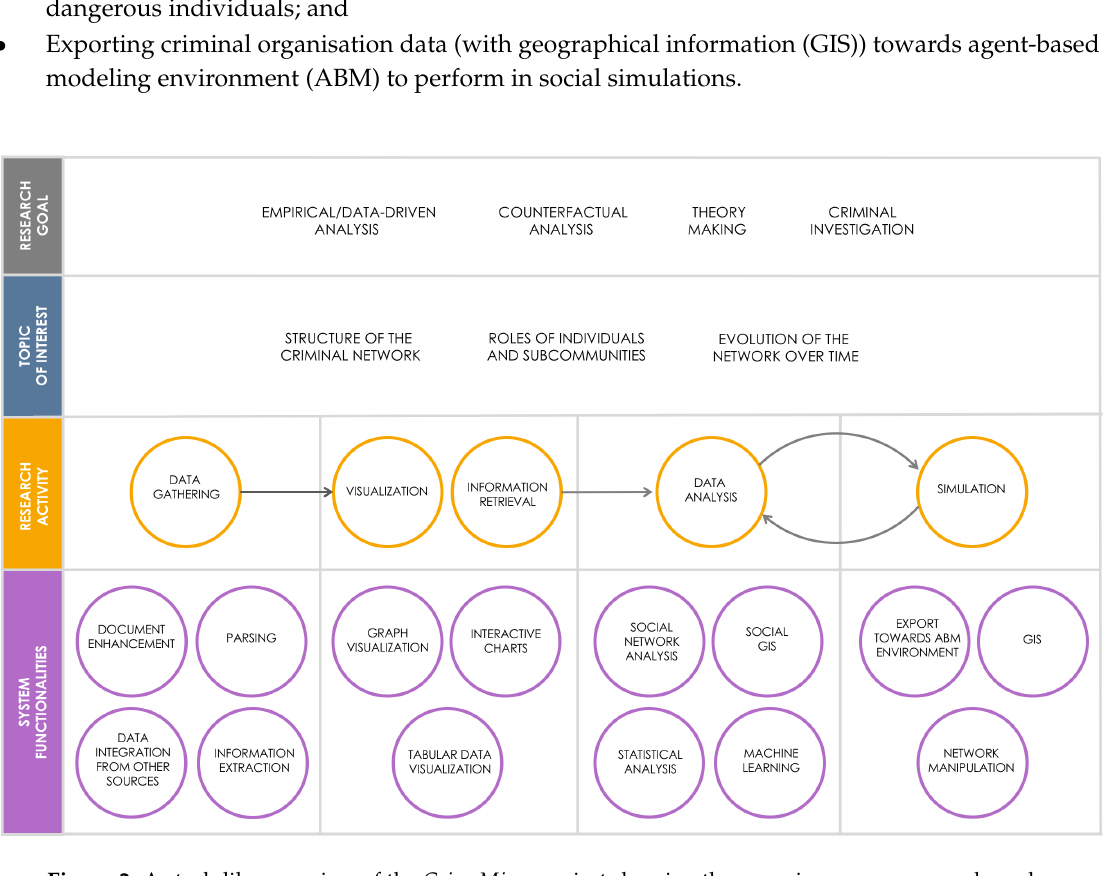
Figure 2. A stack-like overview of the CrimeMiner project showing the mapping among research goals, topics of interest, research activities and system